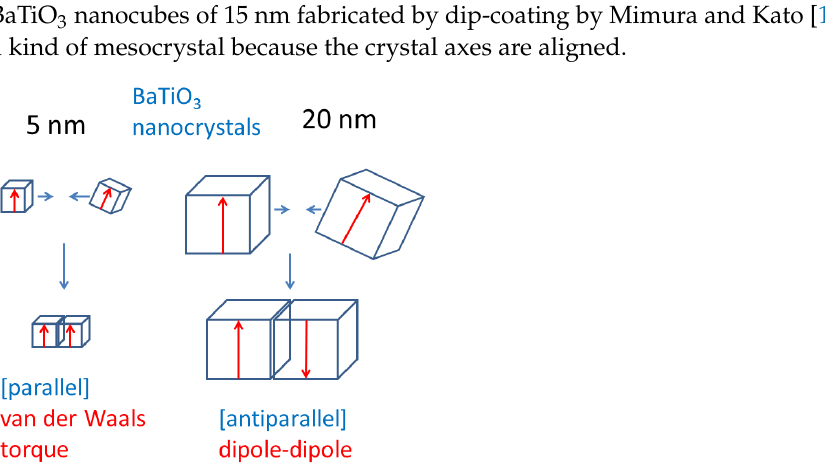
Figure 5. Summary of the results of numerical simulation of the ODE model for oriented attachment of BaTiO 3 nanocrystals in organic solvent (mesitylene). Reprinted with permission from Ref. [85]. Copyright 2015, the American Chemical Society.